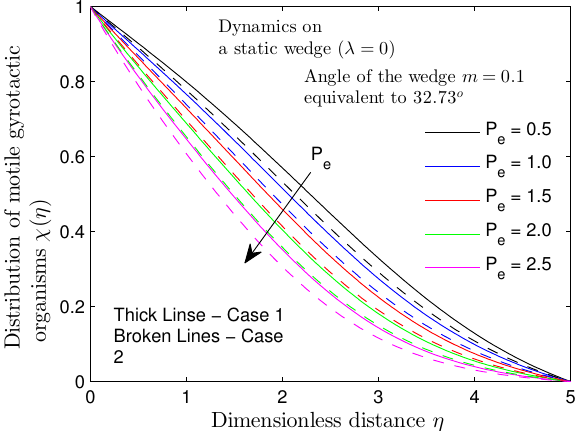
Figure 12. Distribution of motile gyrotactic organisms within the entire domain χ ( η ) with λ when λ = 0—case 2.